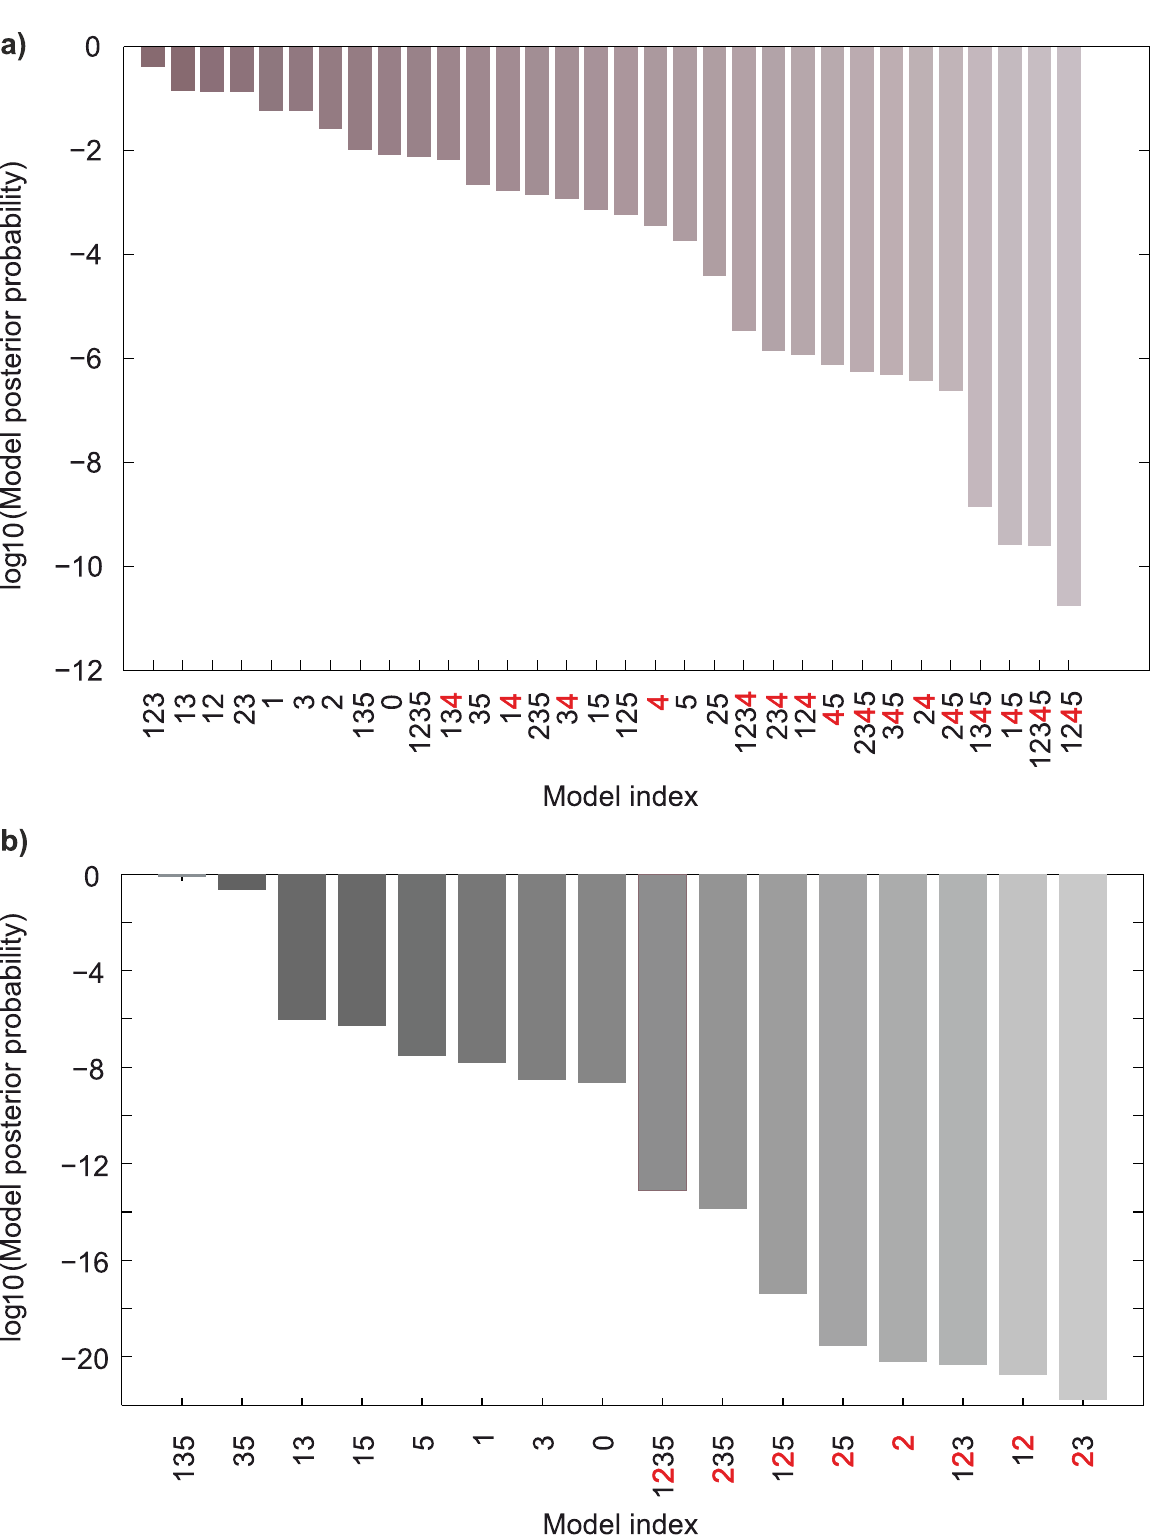
Fig 3. Summary of the results from the two model selection rounds. (a) Logarithm of the model posterior probabilities obtained from averaging the outcomes of three runs of the SMC algorithm using the GATA TF mRNA data, under a uniform model prior. The results of individual runs are reported in